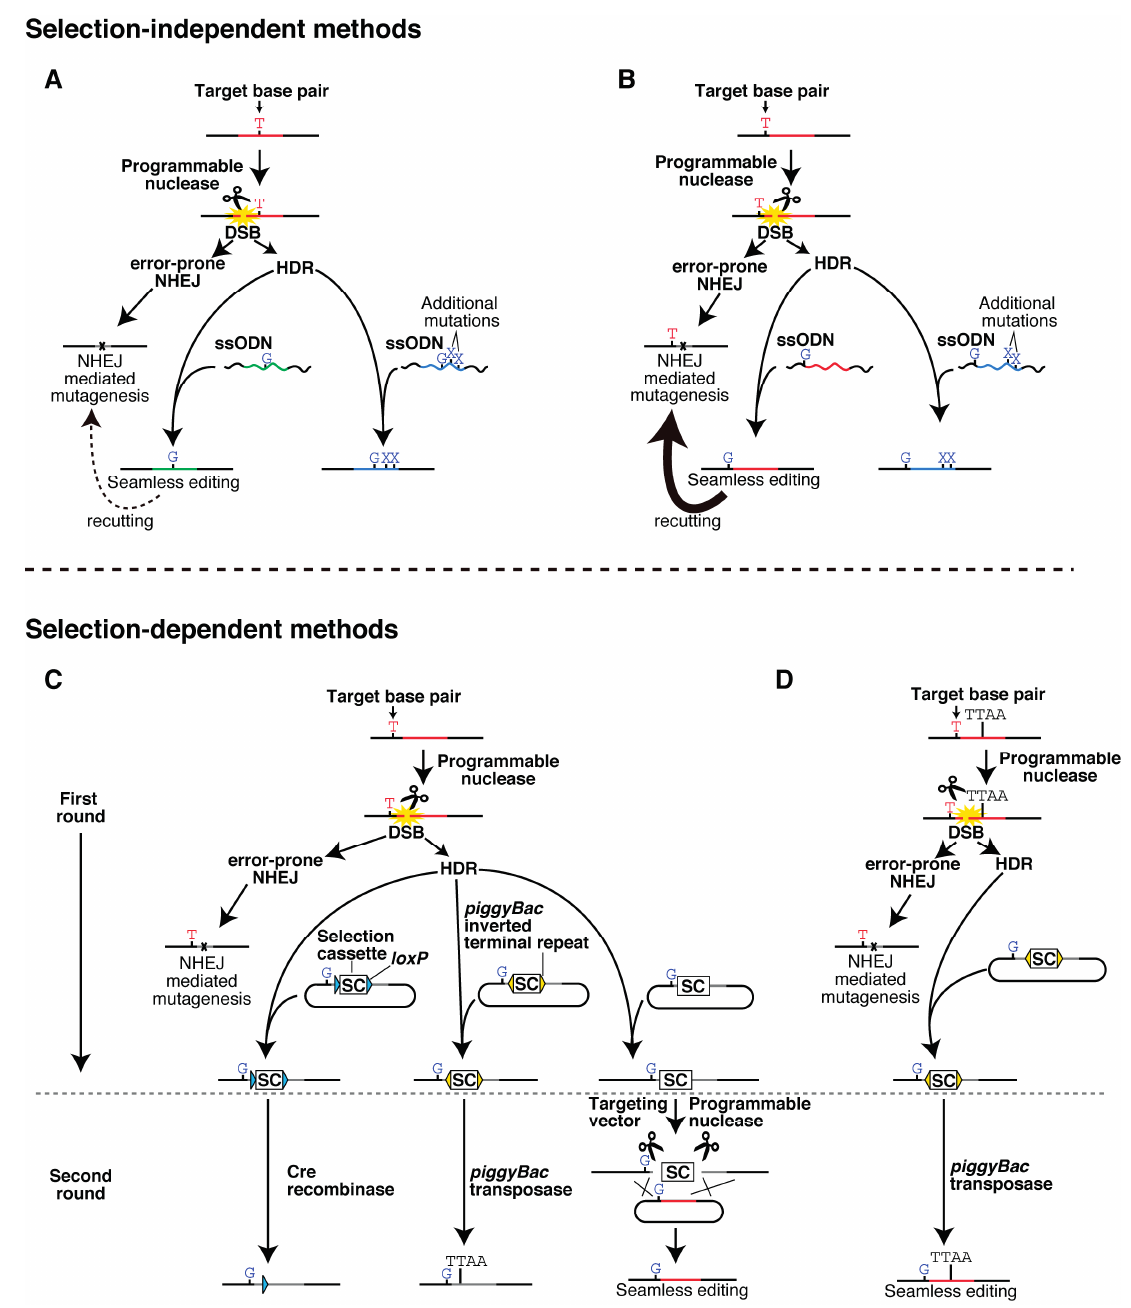
Figure 1. Single-base pair genome editing and related techniques. Schematic representation of methods to engineer a single or a small number of nucleotide substitutions into the genome. ( A , B ) Selection-independent editing of a target base pair within ( A ) and out ( B ) of a sequence recognized by a programmable nuclease; ( C , D ) Selection-dependent editing using different methods to excise the selection marker. piggyBac -excision is illustrated without ( C ) or with ( D ) a TTAA sequence naturally present near or at the target site. Blue, gray, red, and green lines represent programmable nuclease target sites with deletions, insertions, single, and multiple nucleotide substitutions, respectively. Target sites with single nucleotide substitutions may be recut by the programmable nuclease depending on the properties of the enzyme and the location of the substitution. Scissors and yellow star shapes represent programmable endonucleases and DNA double-strand breaks (DSBs),